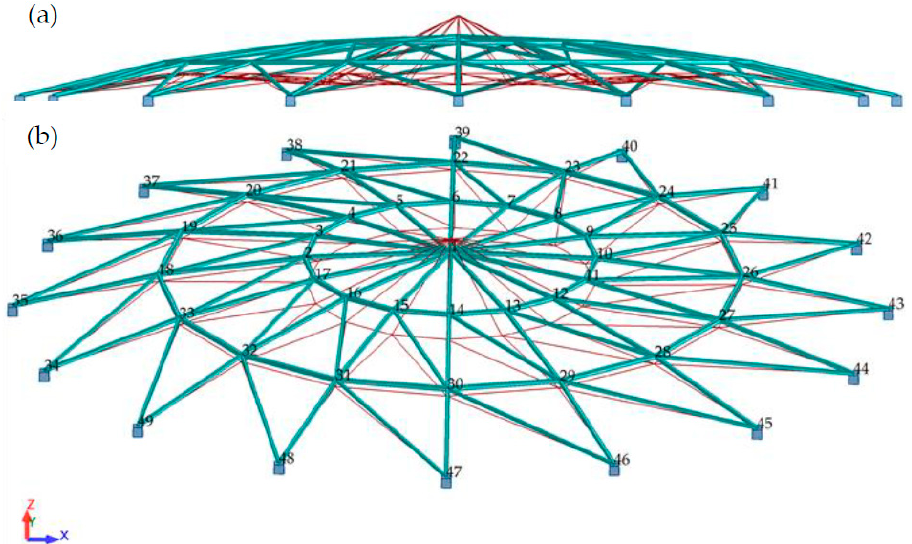
Figure 9. Lattice dome deformation, ( a ) side view, ( b ) 3D view.